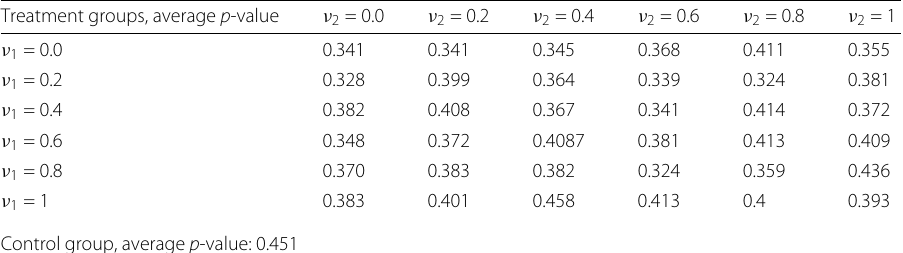
Table 6 Treatment groups: average p -values for goodness-of-fit tests of power-law models to in-degree distributions of interaction networks in online communities, with no onboarding (control group) and with onboarding Treatment groups, average p -value ν 2 = 0.0 ν 2 = 0.2 ν 2 = 0.4 ν 2 =